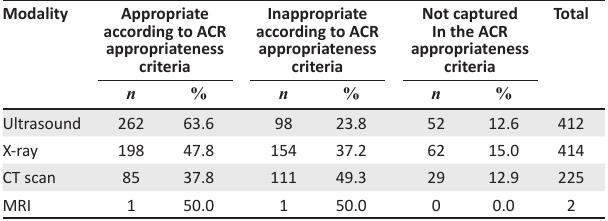
TABLE 1: Appropriateness of imaging modality choice by the doctors at Kenyatta National Hospital Accident and Emergency department based on the American College of Radiology appropriateness criteria.